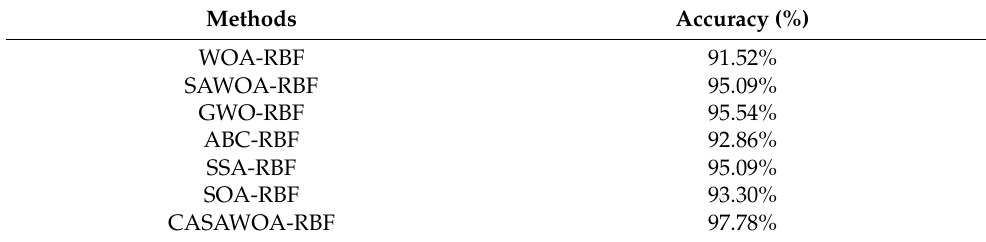
Table 9. The accuracy of each metaheuristic-based model.